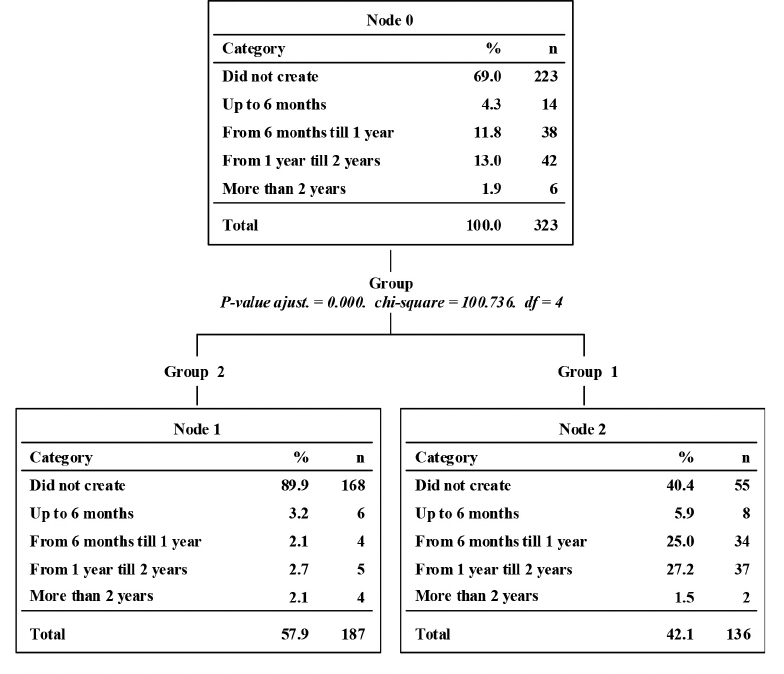
Figure 6. CHAID diagram of relationship between the Time to Creation and the